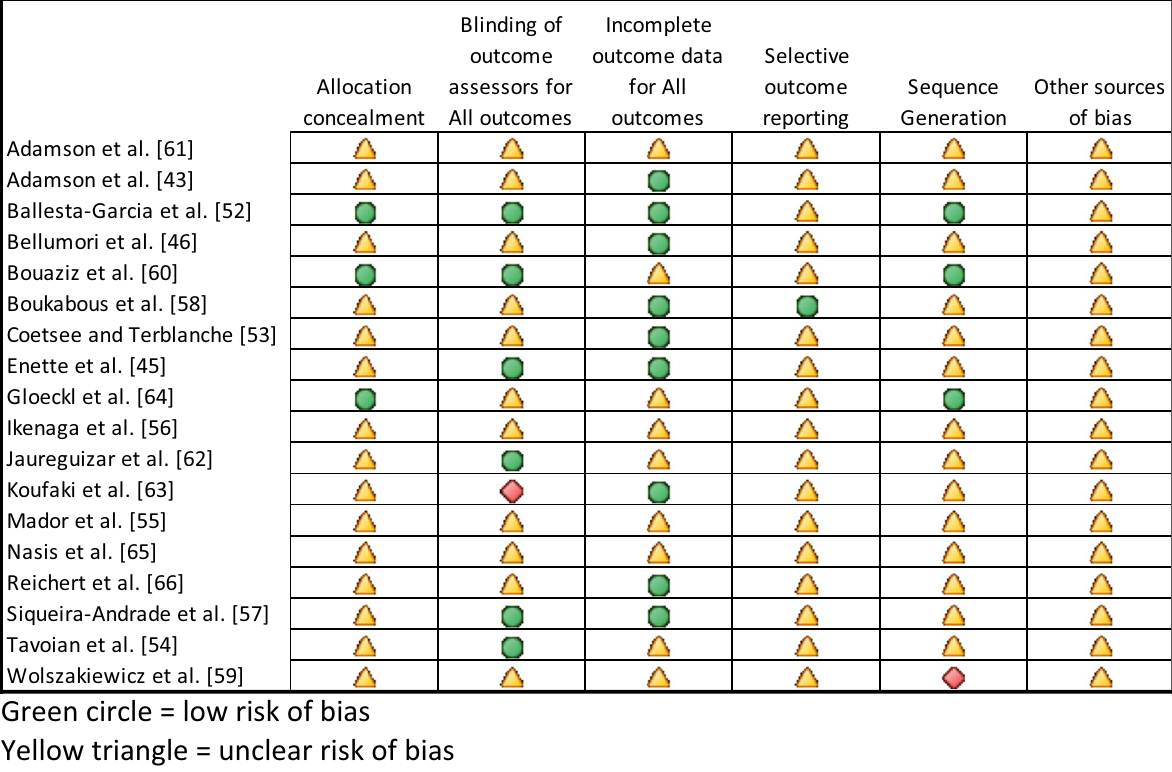
low risk of bias, Yellow triangle =